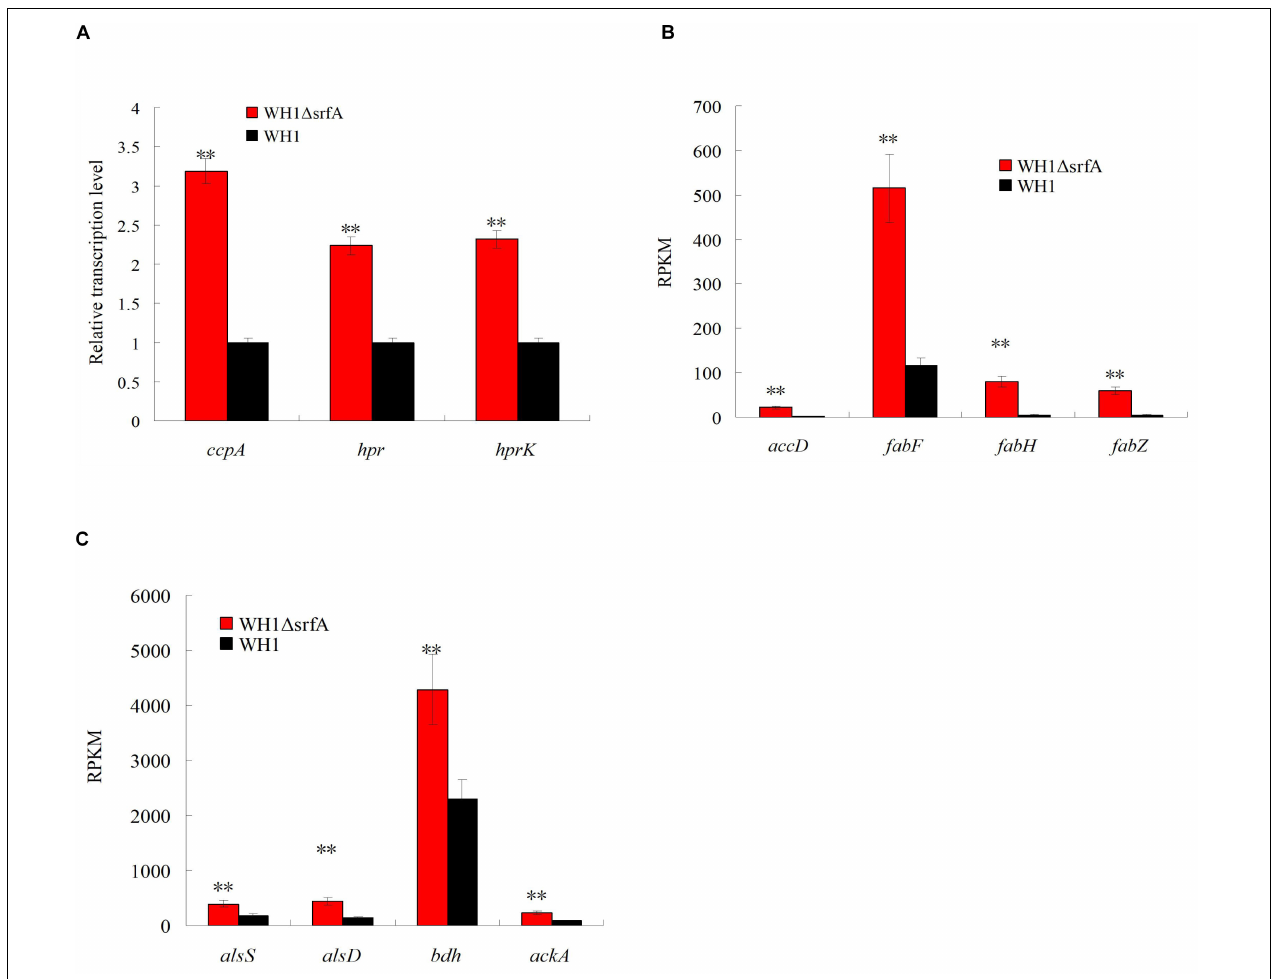
FIGURE 4 | Comparison of the transcription of ccpA and the genes controlled by CcpA between (cid:49) srfA and WH1. (A) Transcription of ccpA , hpr , and hprK . (B) Transcription of genes involved in biosynthesis of fatty acids. (C) Transcription of genes involved in carbon overflow metabolism. (A) was analyzed by qRT-PCR, and (B) and (C) were analyzed on the basis of transcriptomes. Double stars indicate significant difference ( p < 0.01) between (cid:49) srfA and